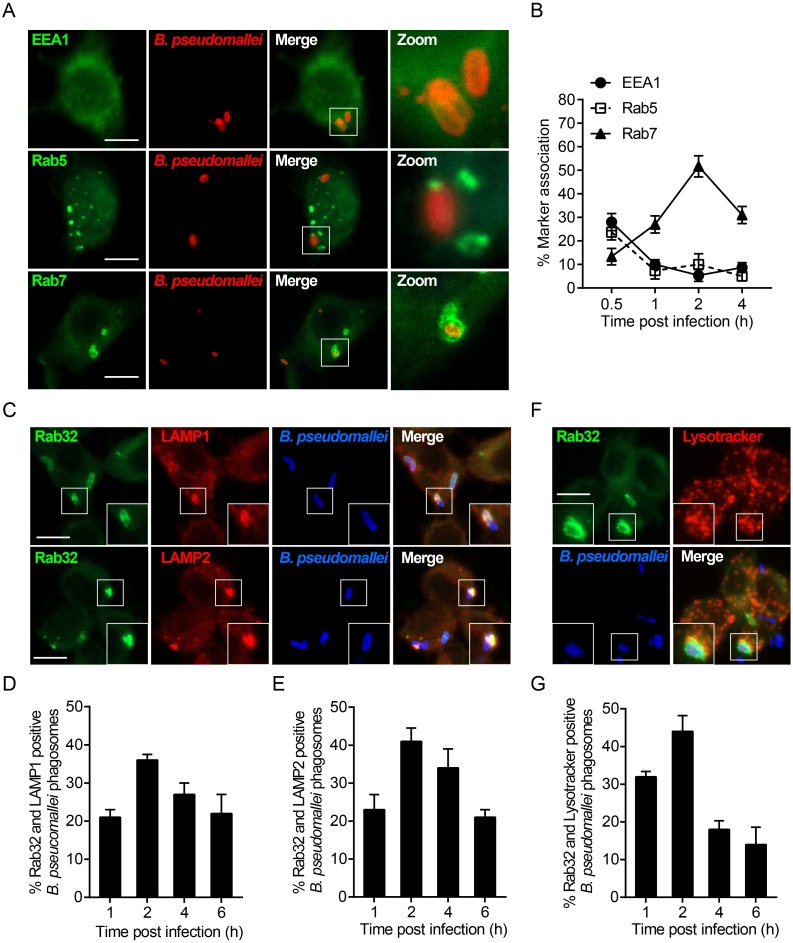
B. pseudomallei resides in a Rab32-labeled compartment with late endosomal features.(A) RAW264.7 cells were infected with B. pseudomallei, at an MOI of 10 for 2 h. Cells were stained with anti-EEA1, anti-Rab5, and anti-Rab7 antibodies (green), or anti-B. pseudomallei antibody (red) and colocalization was determined by confocal microscopy. Scale bar is 5 μm. (B) The percentage of EEA1, Rab5, or Rab7 colocalizing with B. pseudomallei phagosomes was enumerated by fluorescence microscopy. At least 100 bacterial phagosomes were counted for each time point. Results are represented as mean ± S.D. of three independent experiments. (C) RAW264.7 cells expressing EGFP-Rab32 were infected with B. pseudomallei for 2 h, afterwards cells were subjected to immunofluorescence for LAMP1 or LAMP2 (red) and stained with an anti-B. pseudomallei antibody (blue). (D) RAW264.7 cells expressing EGFP-Rab32 were infected with B. pseudomallei, fixed, and immunostained for LAMP1 (red) and B. pseudomallei (blue). B. pseudomallei phagosomes that colocalized with Rab32 and LAMP1 were quantified. Results are the means ± SD of three independent experiments. (E) Quantitative analysis of B. pseudomallei phagosomes that colocalized with Rab32 and LAMP2 as indicated in D. (F) RAW264.7 cells expressing EGFP-Rab32 were incubated with 50 nM Lysotracker (red) for 1 h before infection with B. pseudomallei for 2 h. Cells were stained with anti-B. pseudomallei antibody (blue) and colocalization was determined by confocal microscopy. (G) Quantitative analysis of B. pseudomallei phagosomes that colocalized with Rab32 and Lysotracker as indicated in D. Symbols represent single bacteria or distinct B. pseudomallei groups. Scale bar is 5 μm.